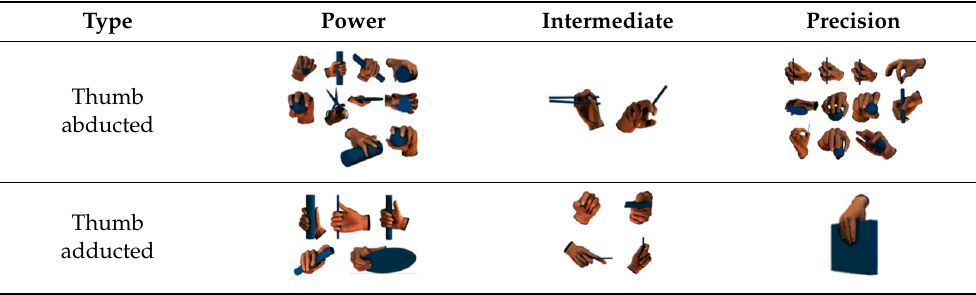
Table 1. Classification of hand grasping motions of patients.